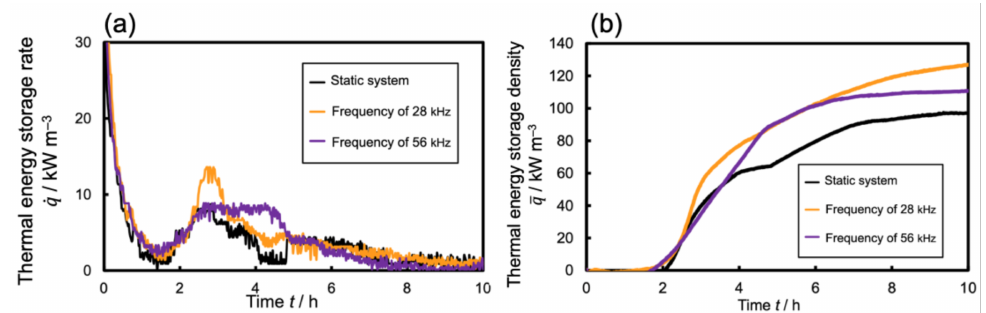
Figure 11. Time evolutions of the thermal energy storage rate and density in the system using an ultrasonic vibration. ( a , b ) depict the thermal energy storage rate and density,